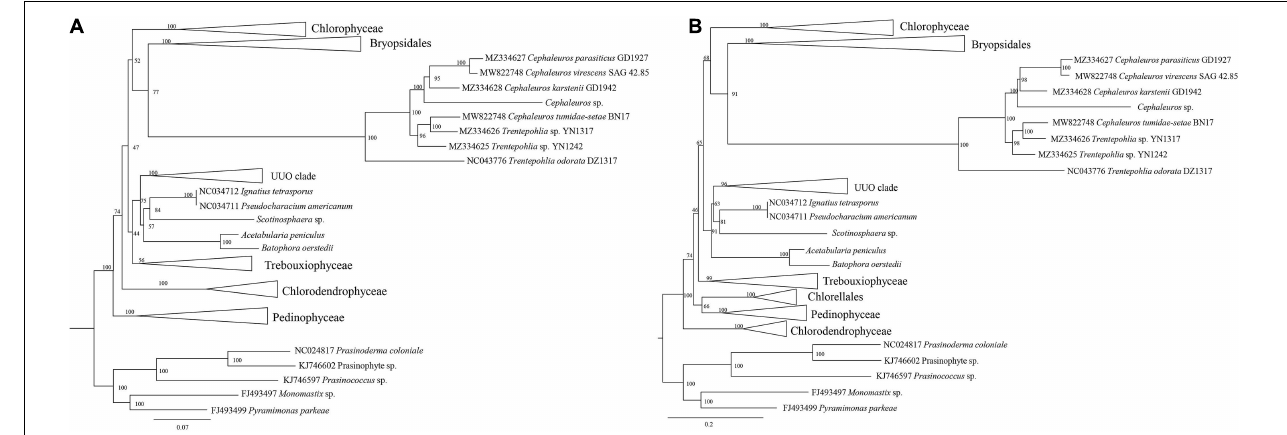
FIGURE 9 | ML phylogenetic tree of the Chlorophyta. (A) ML phylogenetic tree from the nucleotide (nt) alignment (first two codon positions) of 31 concatenated chloroplast genes. Node support is given as maximum-likelihood (ML) bootstrap values. (B) ML phylogenetic tree of the Chlorophyta constructed by using concatenated amino acid (aa) data. Maximum likelihood bootstrap values (1000 replicates) are given near the